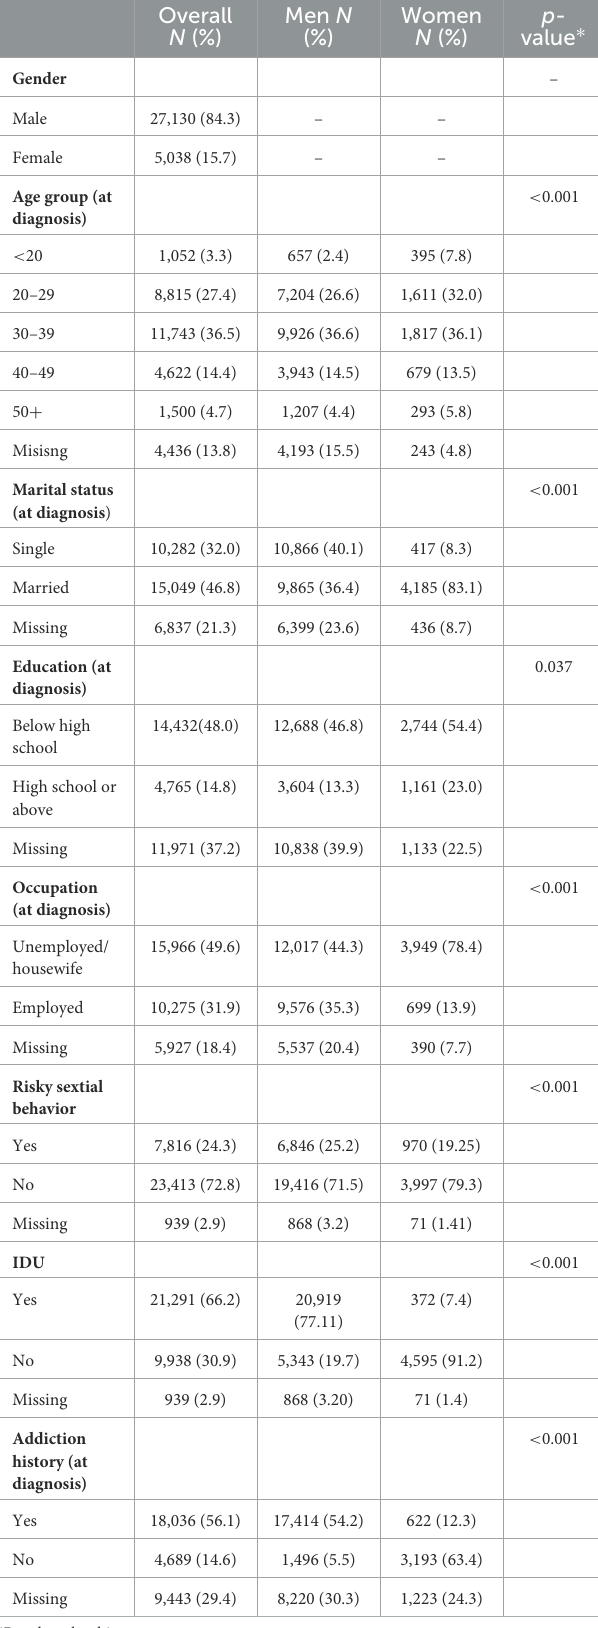
TABLE 1 Descriptive sociodemographic of individuals living with HIV in PLHIV were diagnosed at younger age ( p -for trend < 0.001). In Iran ( N = 32,169). general, of the registered cases, 48.0% had an education lower than high school and 49.6%were unemployed. In females, more Overall Men N Women N (%) N (%) (%) than half of the individuals had an education lower than high school (54.4%) and majority were married (83.1%) at the time of diagnosis (Table